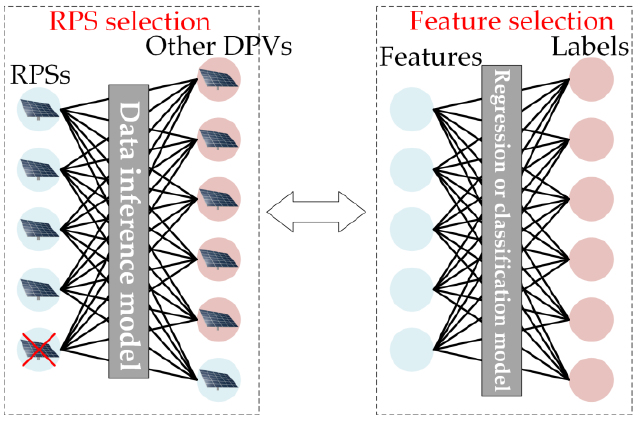
Figure 6. RPS selection and feature selection process.